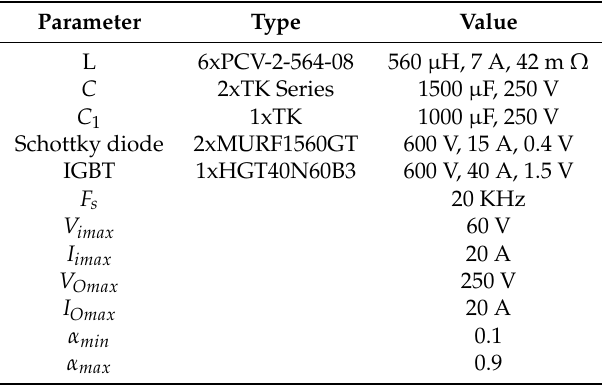
Table 4. Boost converter